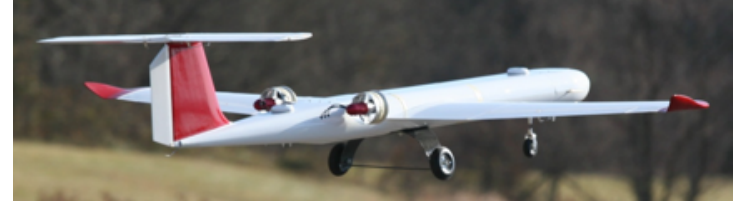
Figure 1. West Virginia University’s Red Phastball research unmanned aerial vehicle